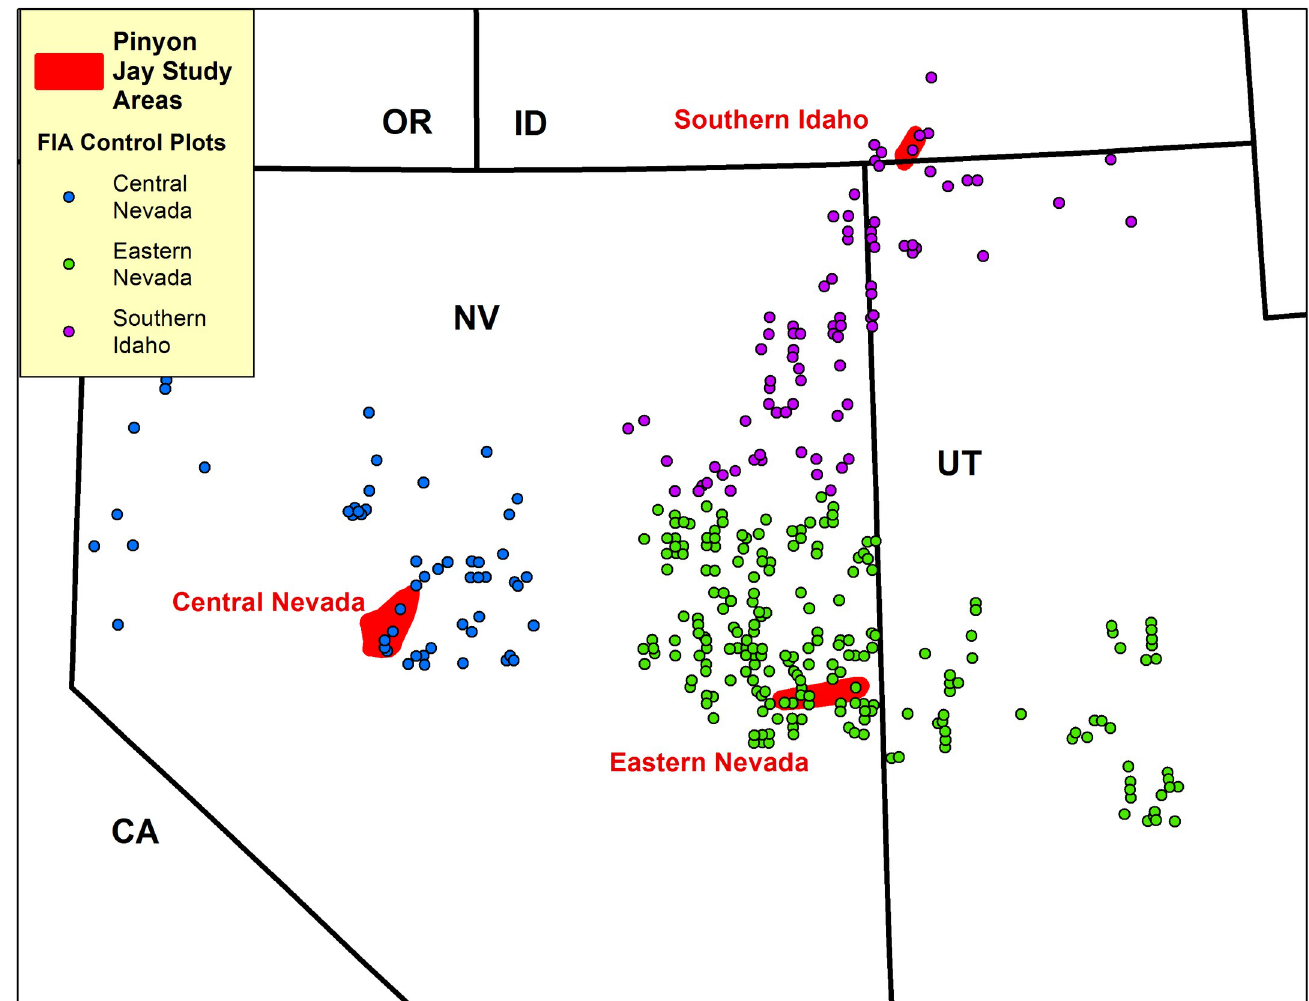
Fig 3. Study areas and control sites. Locations of three Pinyon Jay study areas and FIA plots that served as control sites in Nevada, Idaho, and Utah. FIA plot locations are approximate (i.e. “fuzzed”) to comply with USFS data protection policies. FIA plots are color coded to indicate the Pinyon Jay study area to which they were assigned. Geographical coordinates of multiple Pinyon Jay locations within each study area and control sites are provided in S1